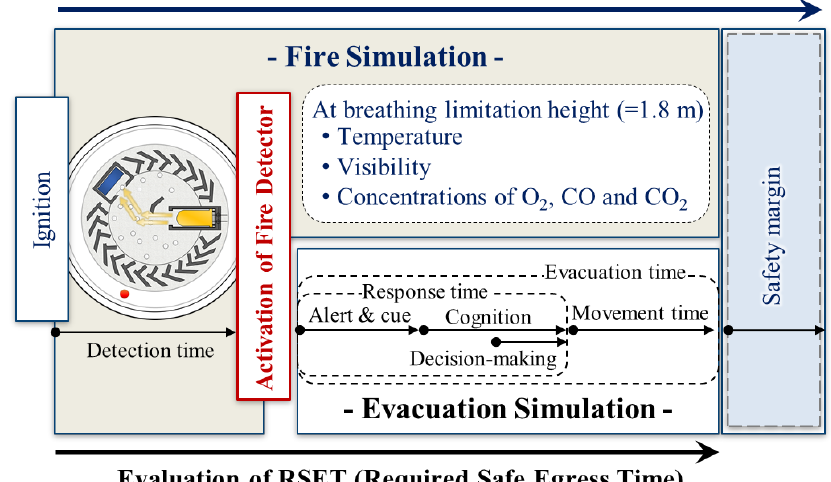
Figure 1. Classification of roles of fire and evacuation simulation for available safe egress time (ASET) and required safe egress time (RSET) evaluations.